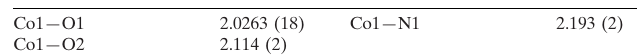
Selected bond lengths (A˚ ).